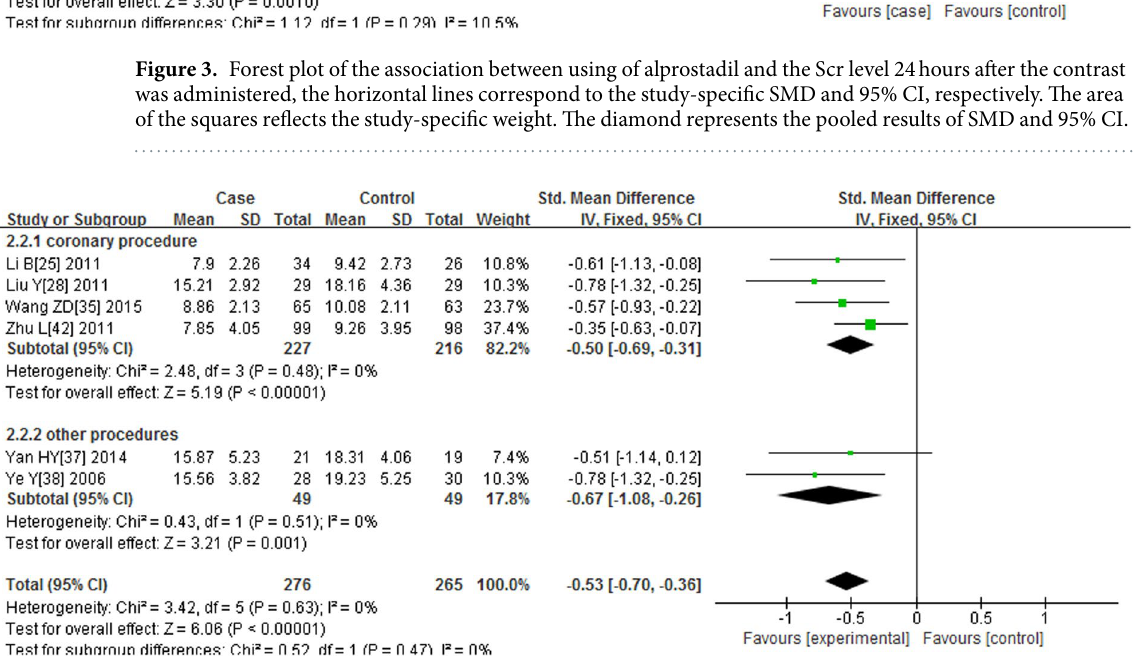
Figure 4. Forest plot of the association between using of alprostadil and the BUN level 48 hours after the contrast was administered, the horizontal lines correspond to the study-specific SMD and 95% CI, respectively. The area of the squares reflects the study-specific weight. The diamond represents the pooled results of SMD and 95%